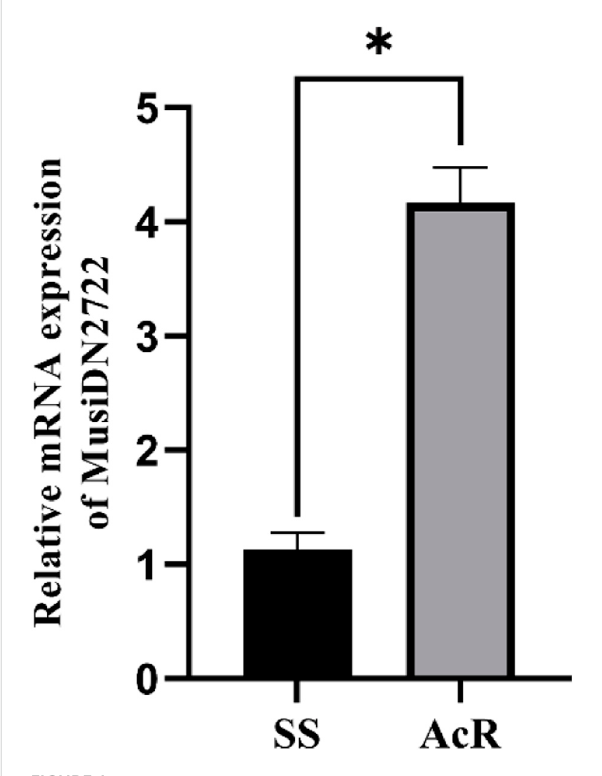
FIGURE 1 Expression of MusiDN2722 in two strains. *signi fi cant difference ( p <